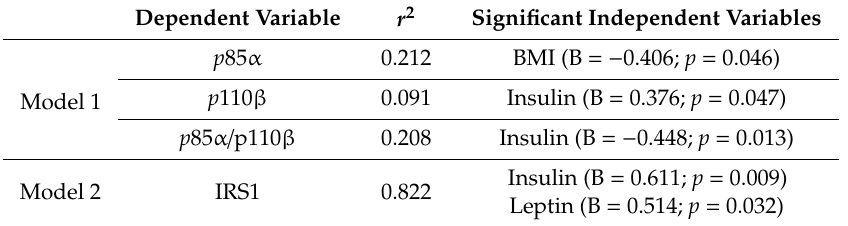
Table 3. Multiple lineal regression models for the mRNA expression of the genes studied.